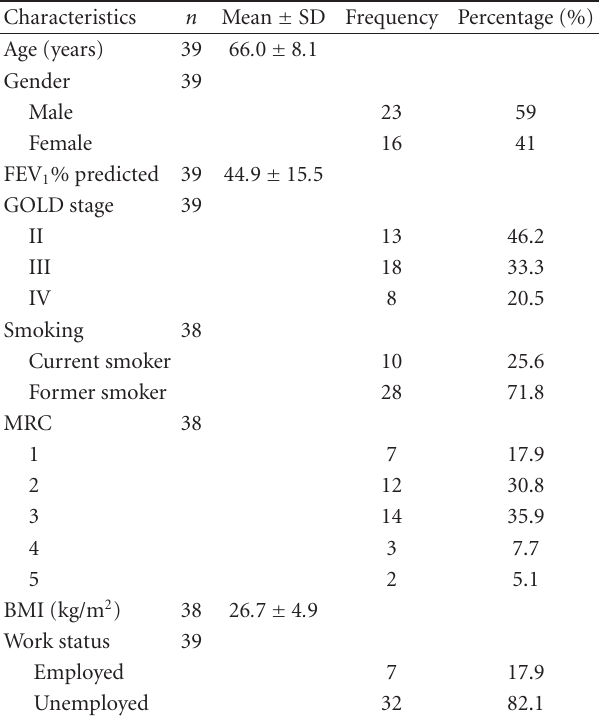
Table 1: Patients’ characteristics and health status.